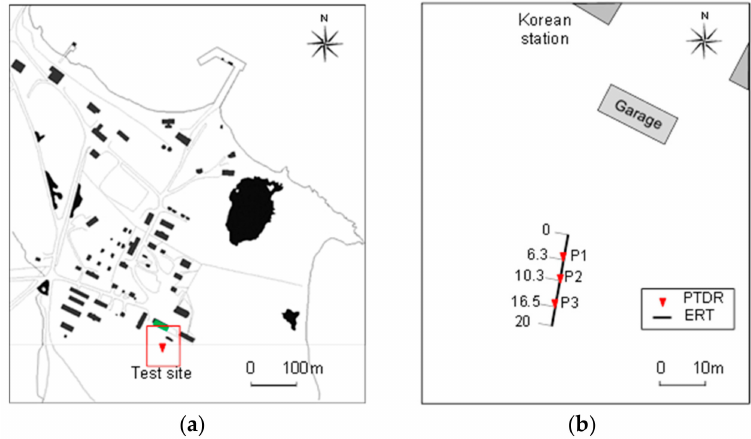
Figure 3. Maps of the study area: ( a ) for Ny-Alesund research district; ( b ) enlarged for the location of the field test. P1, P2, and P3 denote the three different positions. PTDR and ERT indicate the tested positions of PTDR application and electrical resistivity testing.